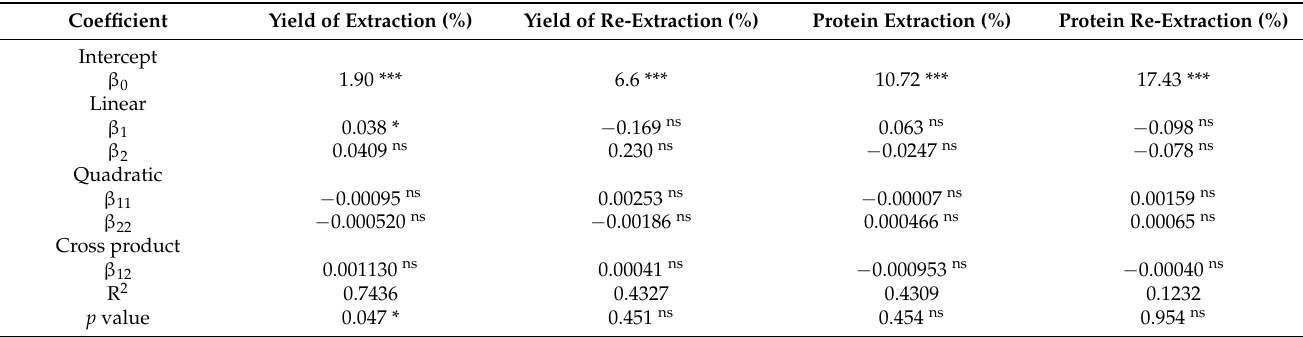
Table 4. Regression coefficients of the predicted second-order polynomial models for the investigated responses from agar extracted by Ultrasound-Assisted